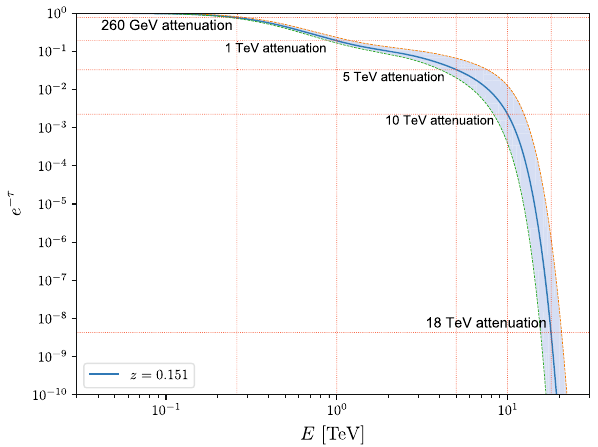
Fig. 9 The EBL E - e − τ plot of redshift z = 0 . 151, with several repre- sentative positions marked out. The model and data are taken from Ref. [50] and